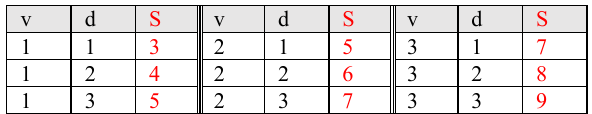
Table 5: Suitability values as function of ranked wind speed (v) and ranked water depth (d)